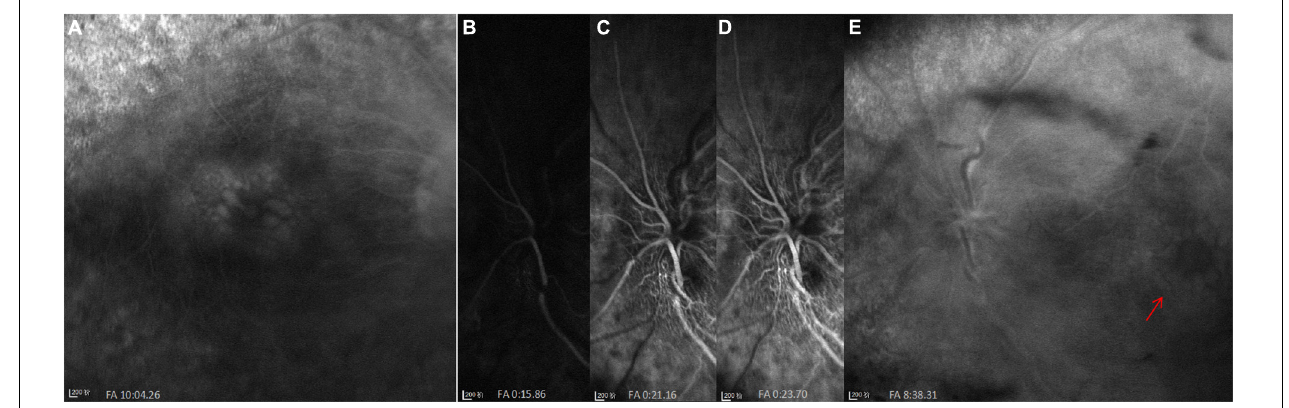
FIGURE 2 | FFA images at initial visit. (A) Cystoid macular edema (CME) in the right eye. (B–E) A significant filling delay of the main veins (especially the superior veins) and CME (red arrow) in the left eye.